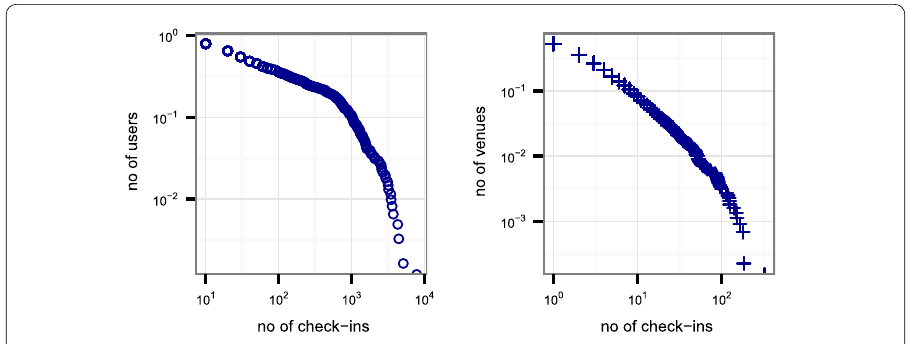
Figure 5 Complementary cumulative distribution function (CCDF) of check-ins in